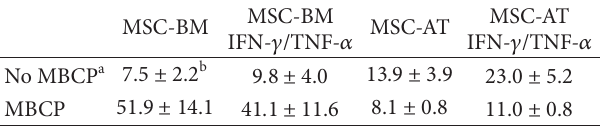
Table 3: Immunogenicity of MSC from bone marrow and adipose tissuecombinedwithMBCPbiomaterialandlicensingbyIFN- 𝛾 and TNF- 𝛼